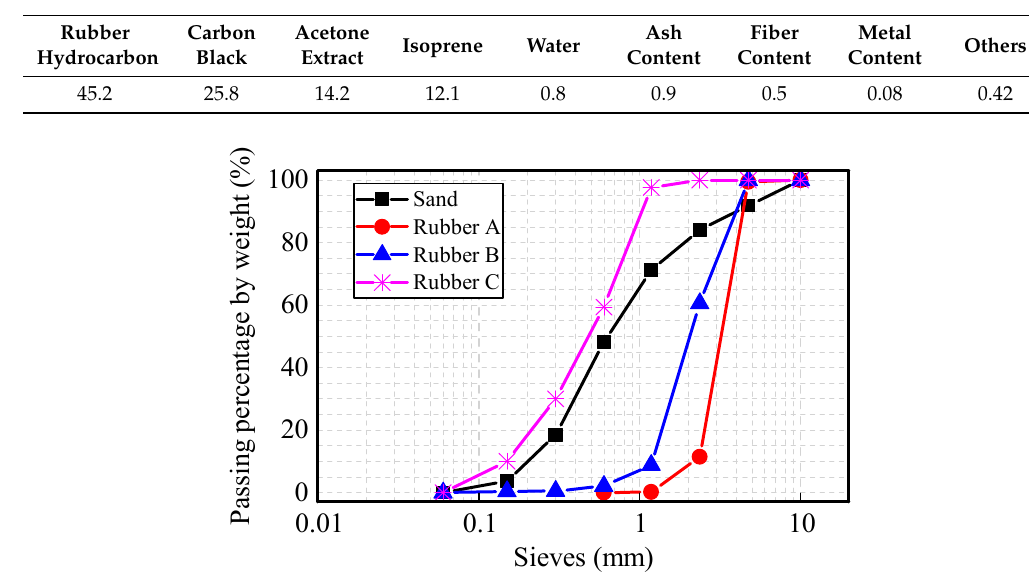
Table 2. Chemical ingredients of crumb rubber (mass fraction %).